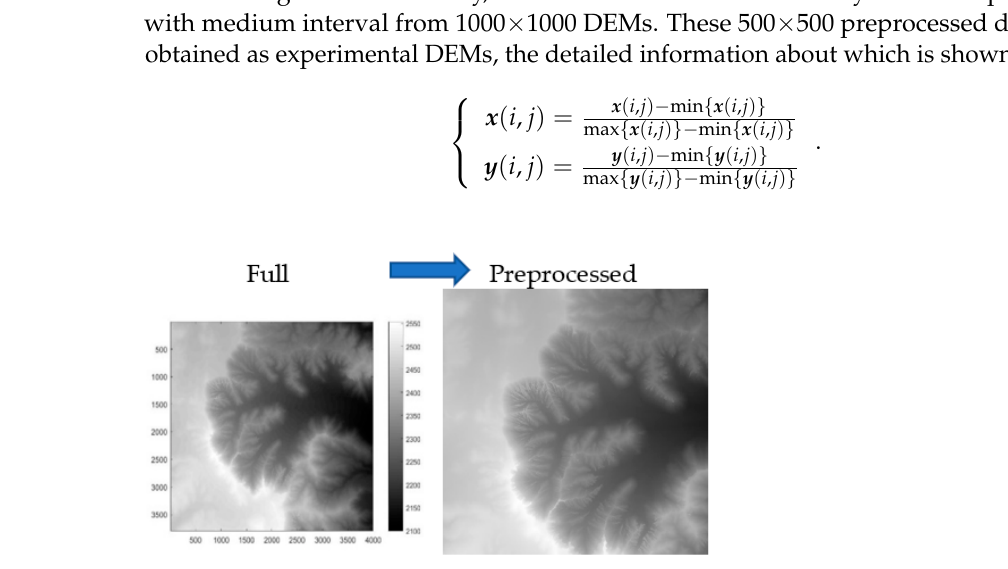
Figure 1. Eroded plateau (Bryce Canyon, UT, USA) [64]: 1000 × 1000 with pixel size of 3 m.